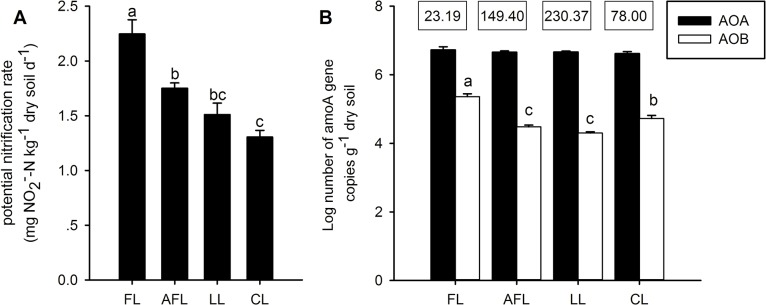
Potential nitrification rate (A), bacterial and archaea amoA genes abundances (B) in different land cover.FL, farmland, AFL, abandoned farmland, LL, Lolium perenne L. land, CL, Caragana korshinskii Kom. land. The amoA gene copy numbers were log-transformed. Values are mean ± standard error (n = 5). Means designated with different letters are significantly different at p < 0.05 based upon Duncan's protected least significant difference test. The ratios of AOA to AOB amoA gene copies are shown in the boxes above the chart.